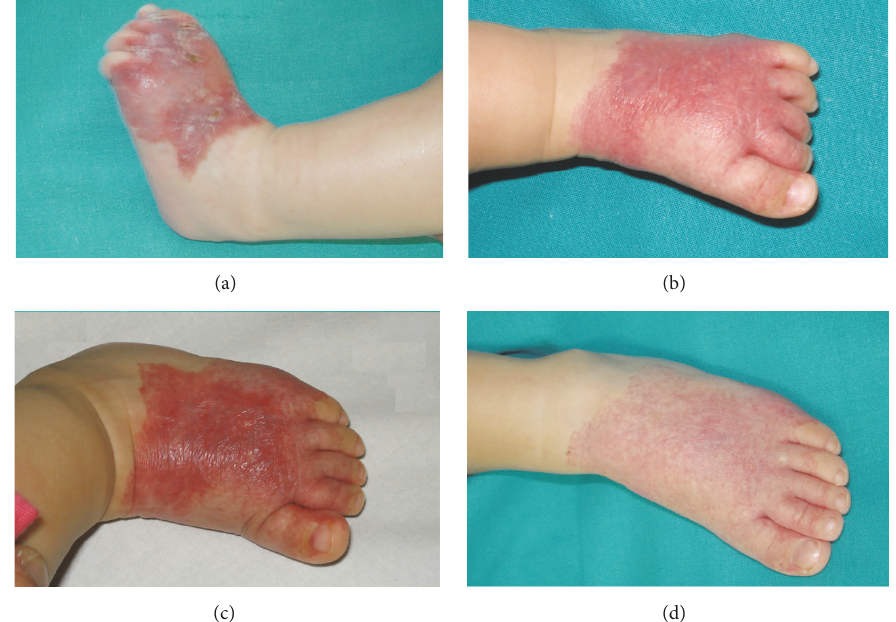
Figure 3: Case 3. (a) An erythematous scaly patch in the dorsal and lateral surface of the left foot extending onto the digits which presented multiple and superficial ulcerations. (b) Response to propranolol after the first month of treatment. (c) Response to propranolol at sixth months of treatment. (d) Spontaneous